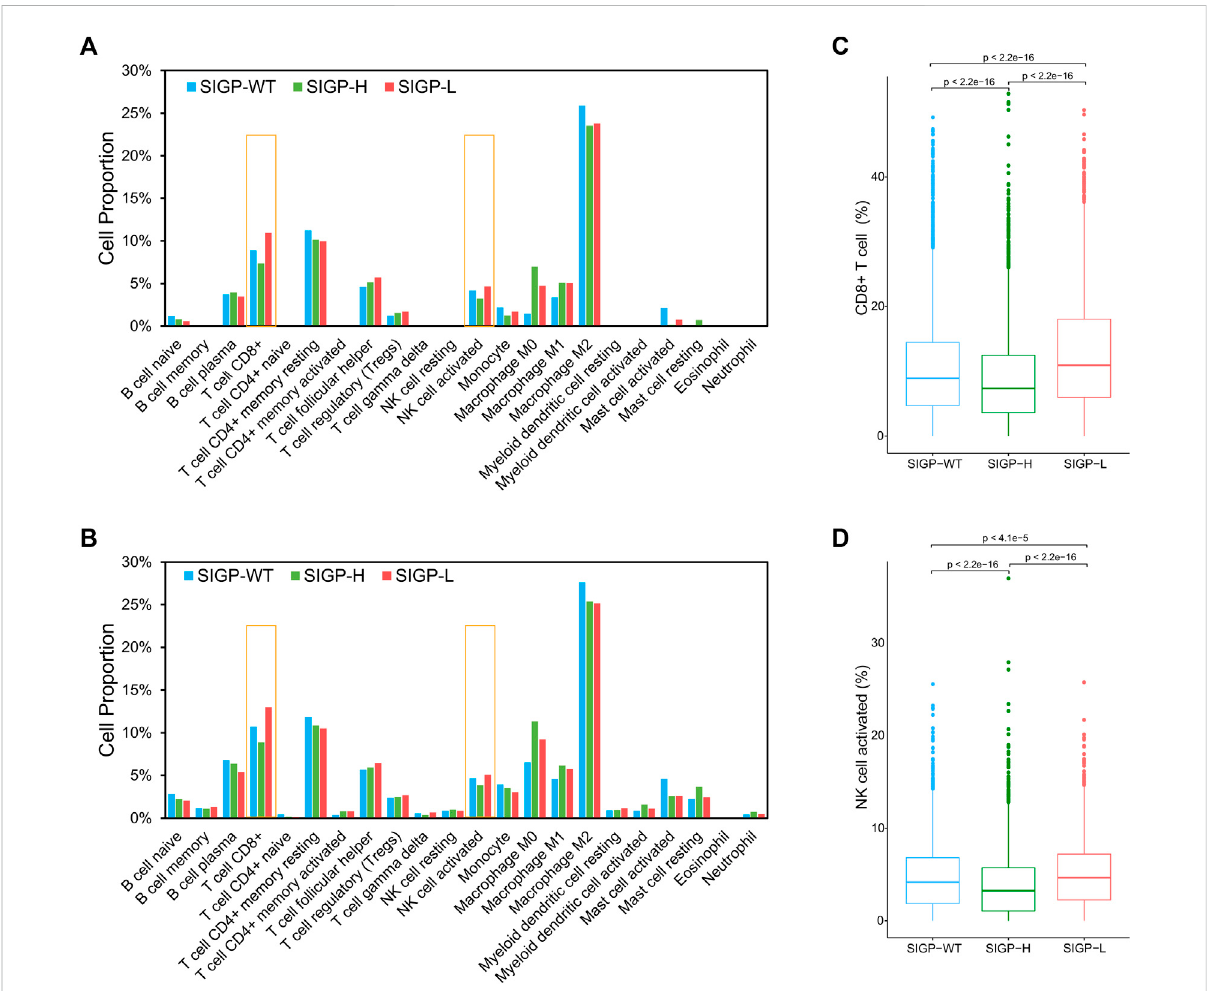
FIGURE 4 Medians and means of CIBERSORT estimates of abundances in a mixed cell population for 22 TIL cell types and boxplots of CIBERSORT estimatesofabundancesforCD8 + TcellsandNKcellactivatedintheTCGAcohort. (A) MediansofCIBERSORT estimatesofabundancesforimmune cell types; (B) Means of CIBERSORT estimates of abundances for immune cell types; (C) Boxplot for CD8 + T cells (Wilcoxon test); (D) Boxplot for NK cell activated (Wilcoxon